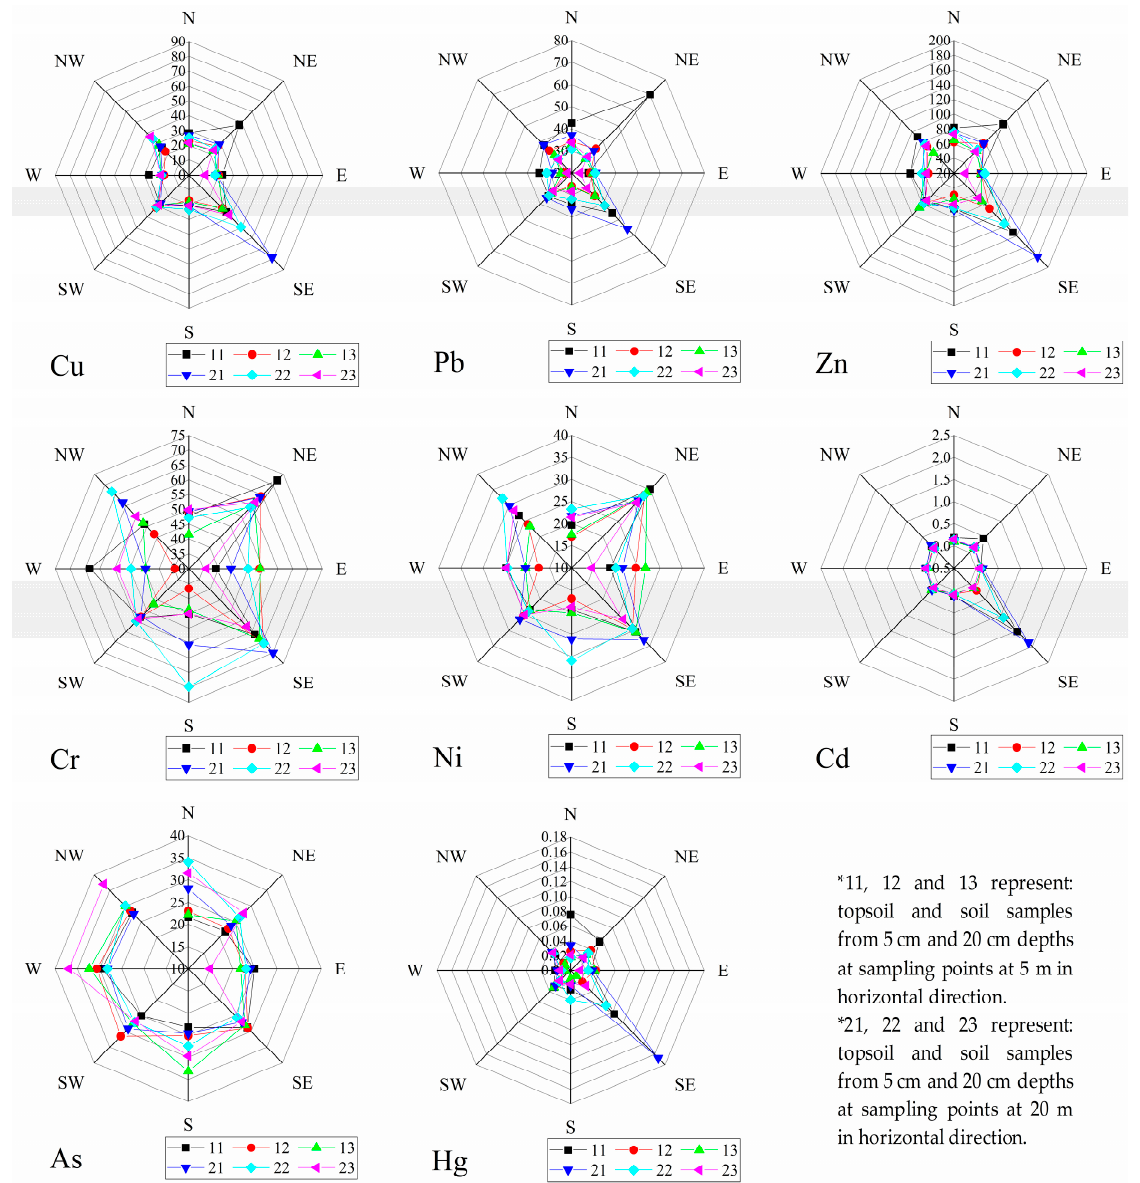
Figure 3. Characteristics of heavy metal concentrations in soil at different depths.